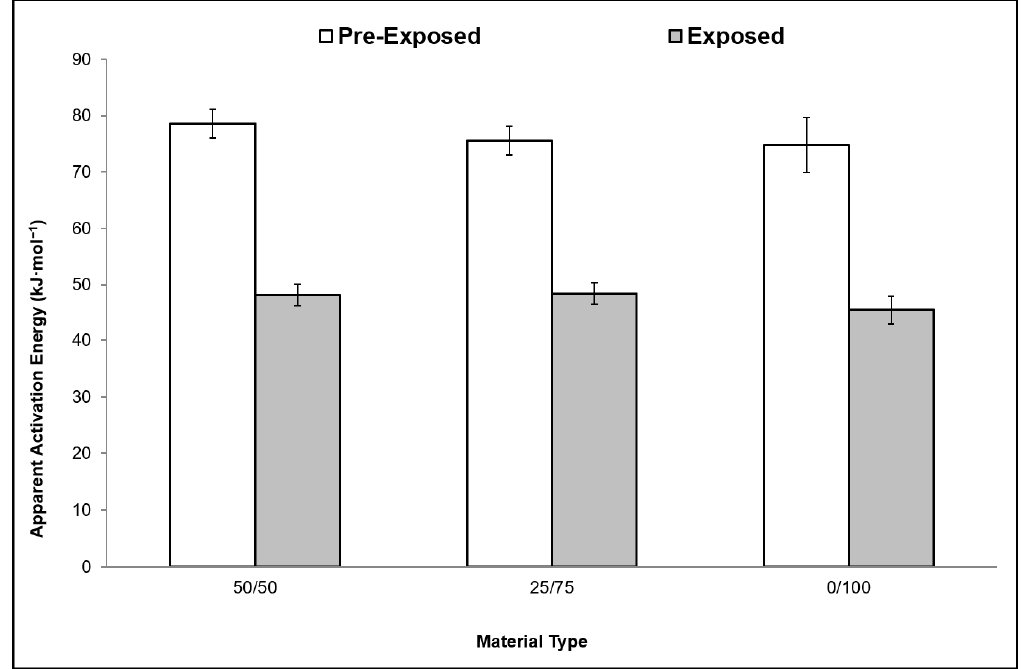
Figure 8. Variation in apparent activation energy between the pre-exposed and exposed materials determined using the Criado method.